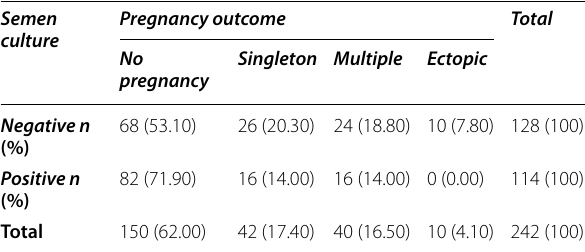
Table 3 Relationship between semen culture result and pregnancy outcome